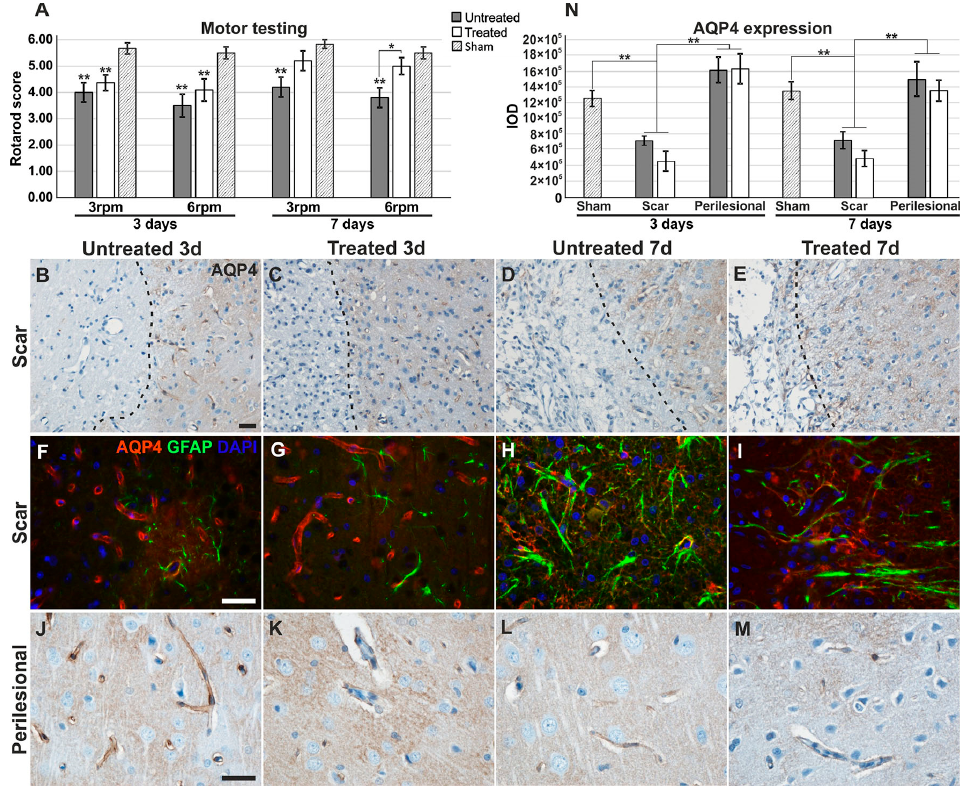
Figure 1. Motor testing and comparative aquaporin expression patterns. ( A ) Motor performances showed an overall increase for TGN-020-treated animals, with a significant difference for the 6 rpm testing at 7 days; ( B – I ) Aquaporin-4 (Aqp4) expression is decreased in the glial feltwork around the infarct tissue while still retaining strong vascular expression, and in perilesional regions ( J – M ) it is more intense and diffusely present in the glial feltwork, both for 3-day treated and untreated animals. At 7 days, Aqp4 is present around the infarct, less in the blood vessels and more in the astrocytes forming the more robust scar, and is overall, more intense in untreated animals ( D , E , H , I ); ( J – M ) Further from the infarct, it is diffuse in the neuropil for the untreated animals and more petechial in the treated rats; ( N ) Integrated optical density (IOD) of the immunohistochemistry staining shows significant lower values for scar regions for both treated and untreated animals at both time points. Data are expressed as the means ± SEM, * p < 0.05, ** p < 0.01 using a one-way ANOVA followed by a post hoc Fisher’s LSD test, n = 5–6/group. Unless indicated, significance is shown for differences from the measurements in sham animals. Dotted lines in the micrographs delineate the infarct areas. Scale bars represent 20 µm.